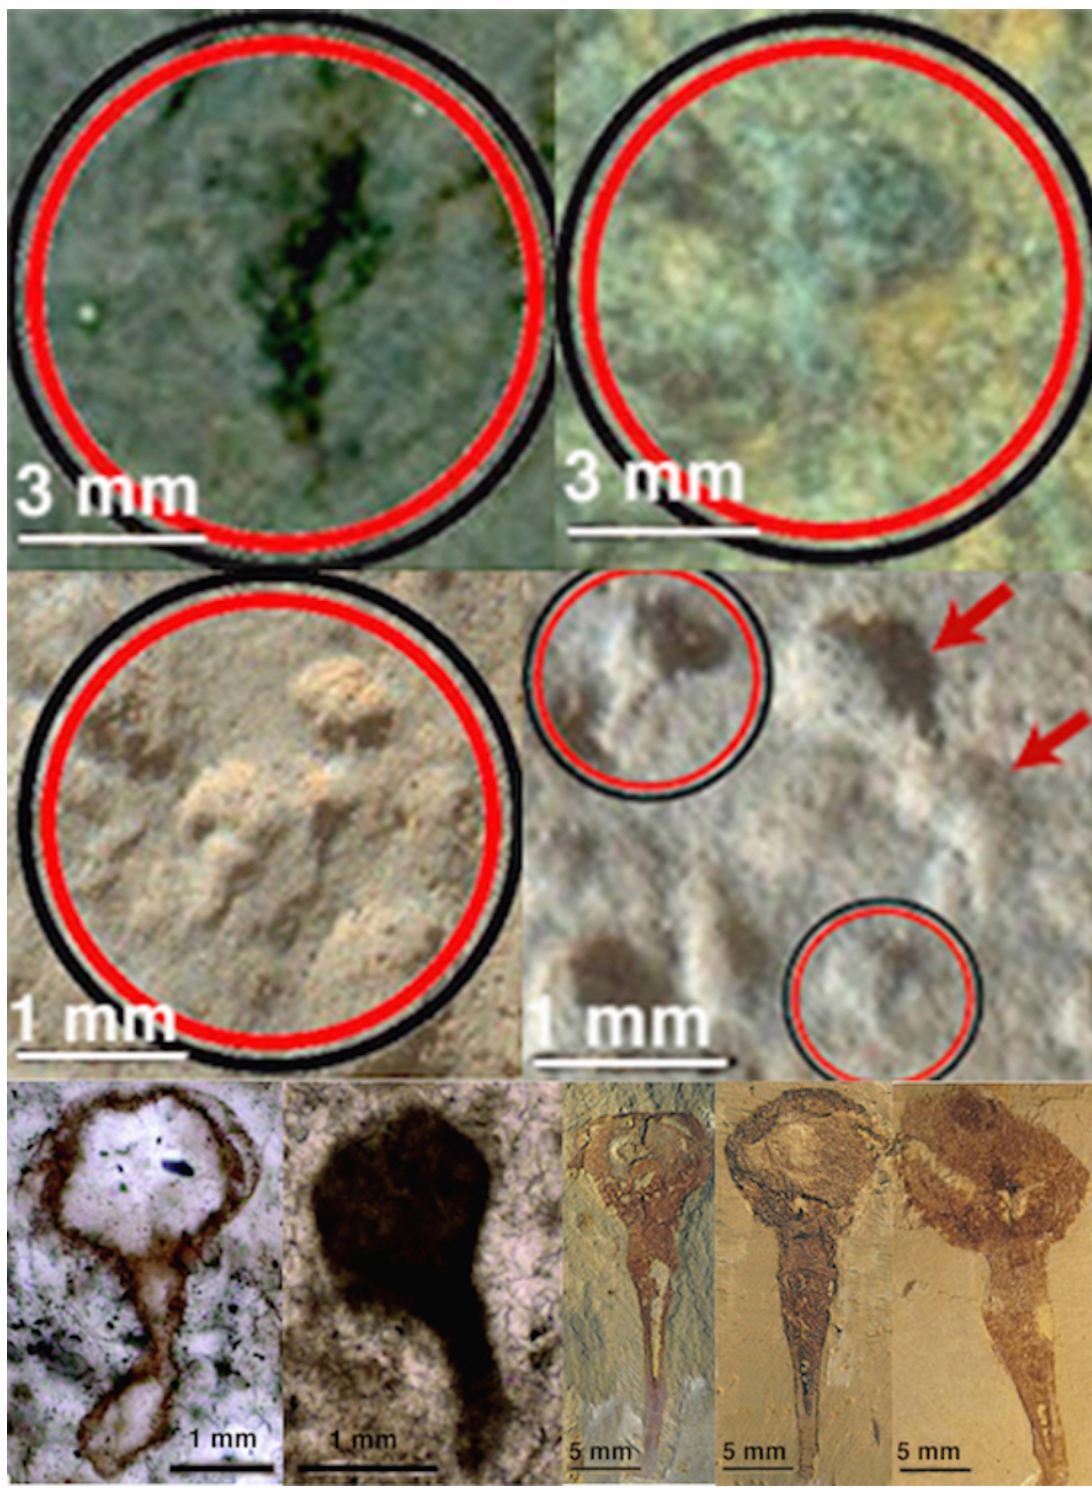
Figure 3. (First row): Sol 809 and Sol 869. (Second row) Sol 905 and Sol 905. Specimens photographed in Gale Crater and that are quan- titatively and statistically nearly identical to Ediacaran fossils of Namacalathus (two, bottom left) and (with the exception of tail length) Cambrian fossils of Lophotrochozoa (three bottom right). Photos of Namacalathus reproduced from and courtesy of Kontorovich et al. 2008. Photos of Lophotrochozoa reproduced from and courtesy of Zhang et al.